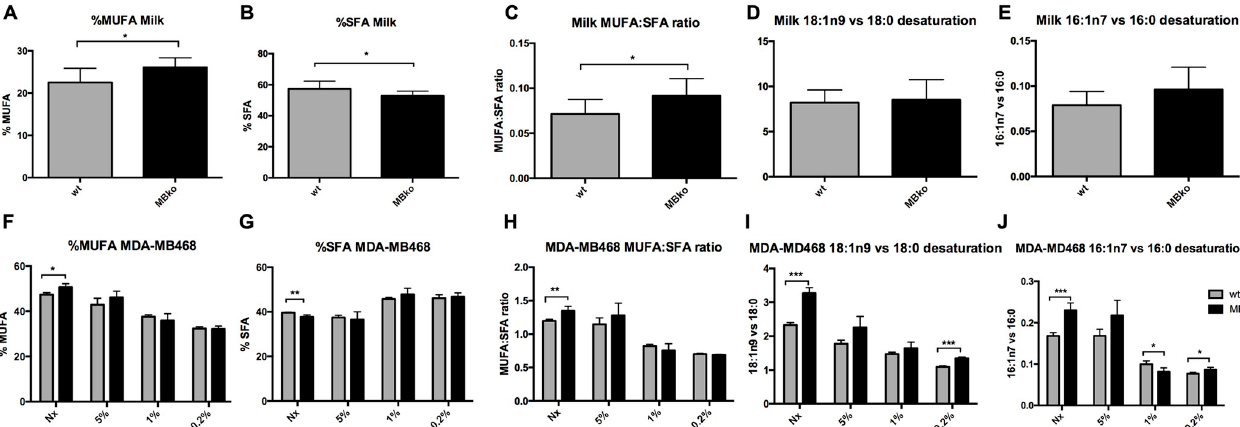
Fig 2. Impact of MB on indices of saturated and monounsaturated fatty acids. FA compositions of the mouse milk and MDA-MB468 cells were presented as the percent of major MUFAs (C16 and C18, n9 and n7 species; A and F , respectively) or SFAs (C12, C14, C16, C18, C20; B and G , respectively) among total FAs amount, and as the MUFA vs. SFA ratio ( C and H , respectively). The delta-9 desaturation index was measured as oleate (C18:1n9) vs. stearate (C18:0) ratio ( D and I , respectively) or palmitoleate (C16:1n7) vs. palmitate (C16:0) ratio ( E and J respectively). MDA-MB468 cells were exposed to four O 2 tensions for 72 hrs: Nx, 5% and 1% O 2 (oxygenated MB), 0.2% O 2 (deoxygenated MB). In all graphs, MBwt as grey bars versus MBko black. Students t-test was used for statistics (n = 4–8); mean ± SD. � p � 0.05, �� p � 0.01, ��� p �